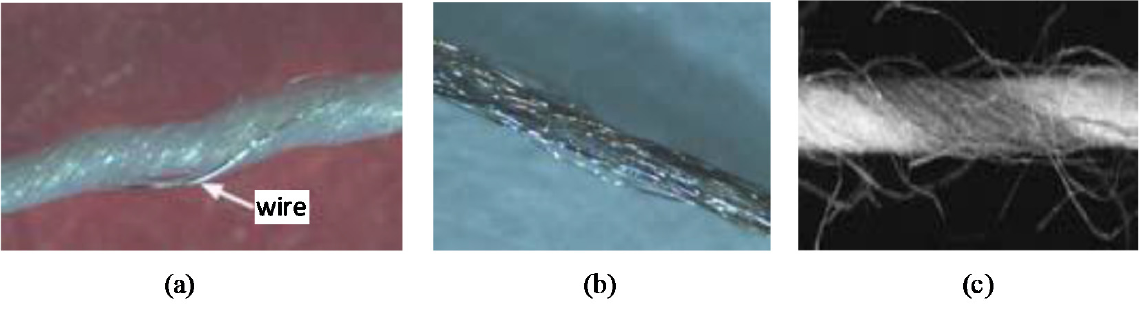
layers, ELITEX ® . Nylon 66 threads were coated with a thin silver layer in [90].